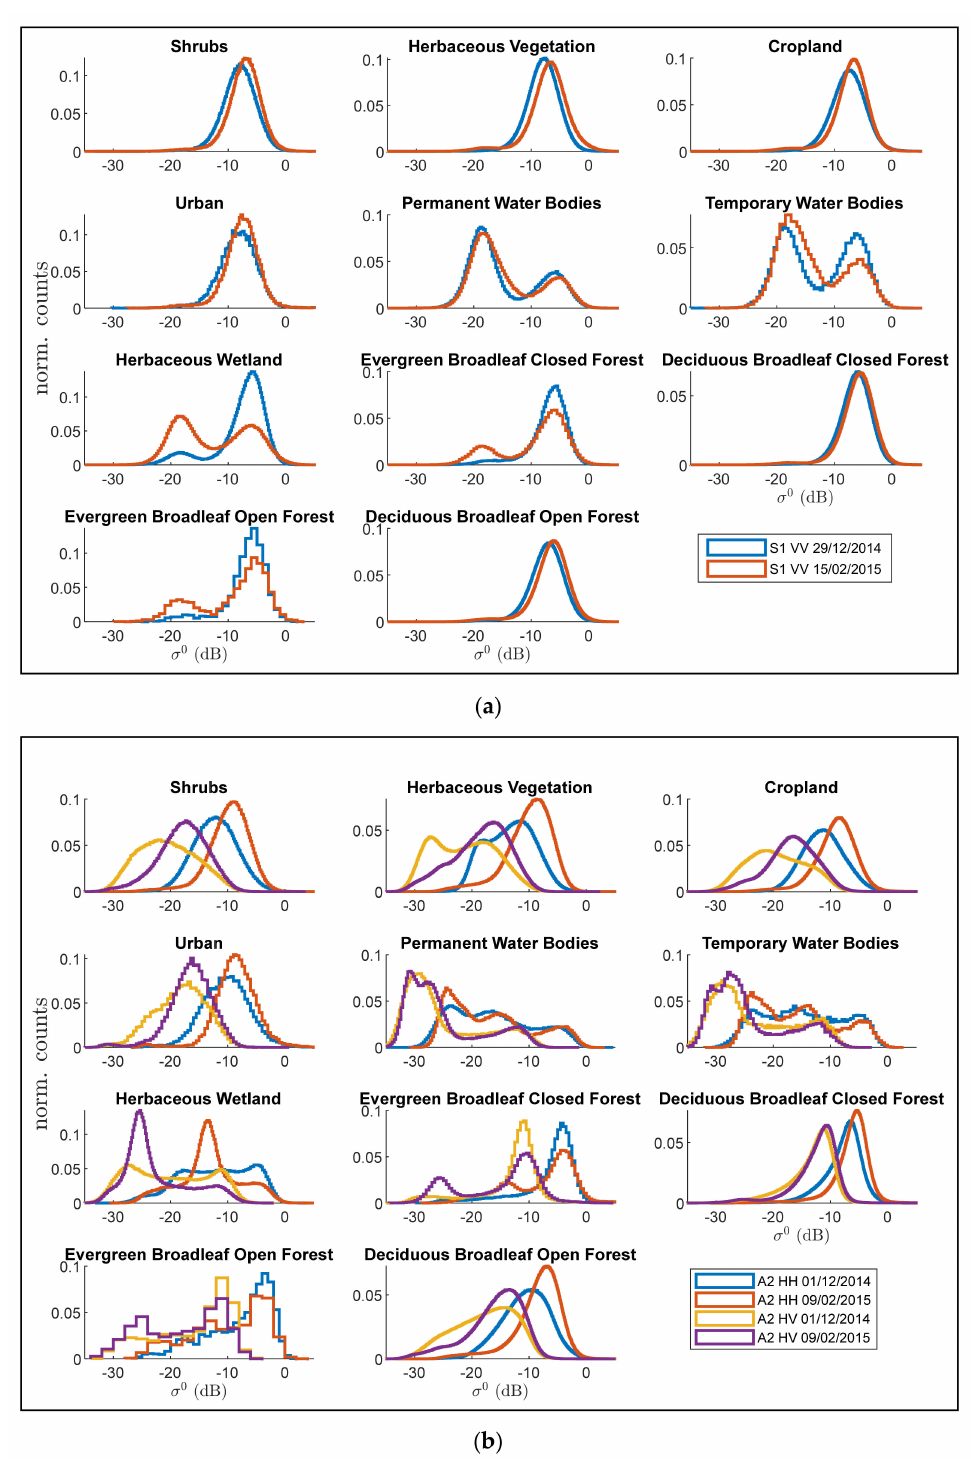
Figure 7. Histograms of synthetic aperture radar (SAR) intensities over the CORINE land cover classes found on the image, for ( a ) C band, ( b ) L